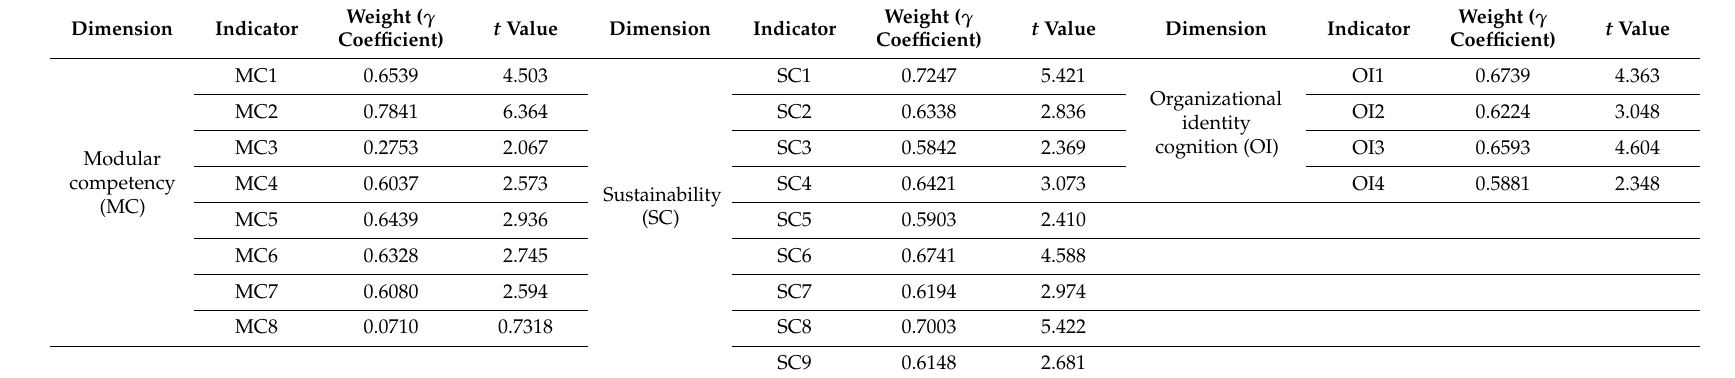
Table 3. Weights and t values of